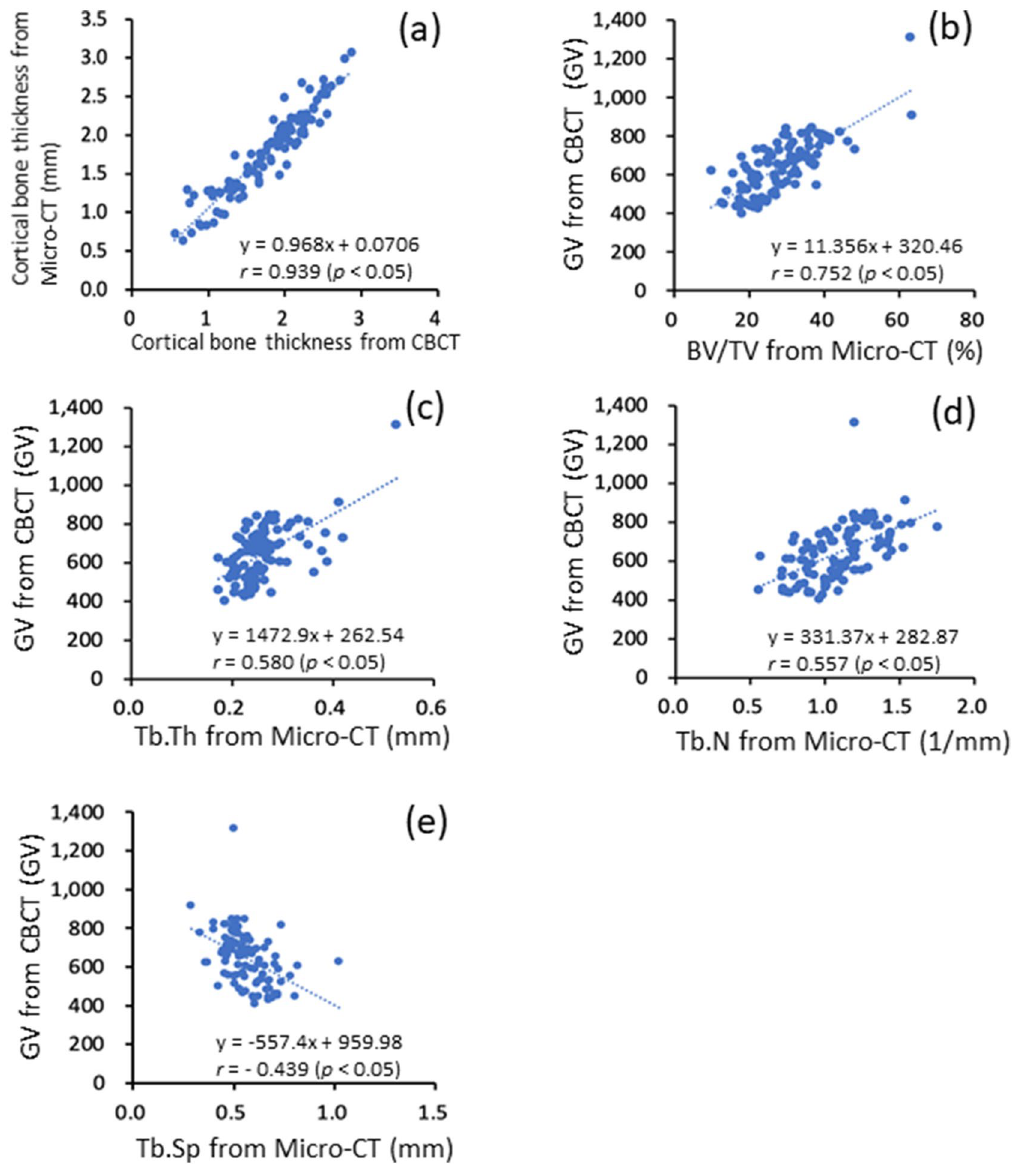
Figure 1. ( a ) Relationship between cortical bone thickness measured from CBCT and micro-CT images. ( b – e ) Relationship between cancellous bone density measured from CBCT images and four trabecular bone microstructural parameters measured from micro-CT images.